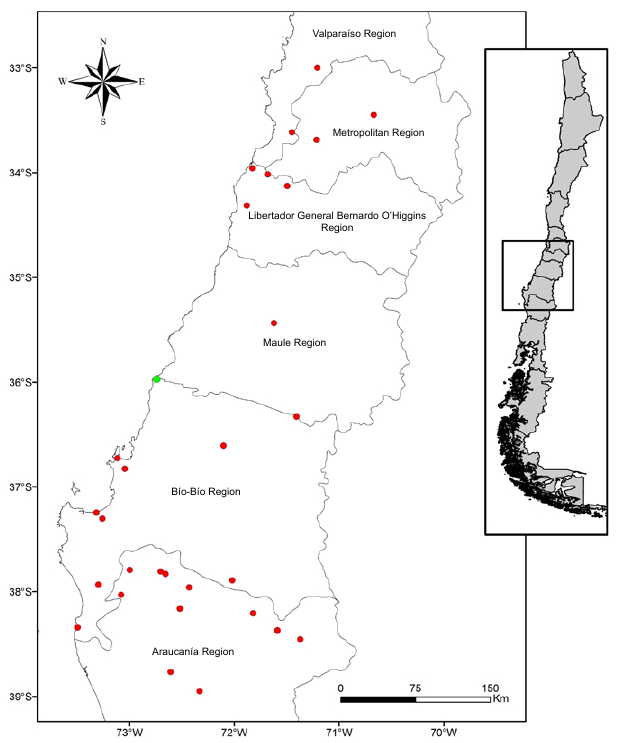
Figure 1. Distribution map of Batrachyla taeniata . Red dots represent historic localities (records obtained from Sallaberry et al. 1981; Brieva and Formas 2001; Cuevas and Cifuentes 2010; Correa et al. 2014). The green dot corresponds to the new